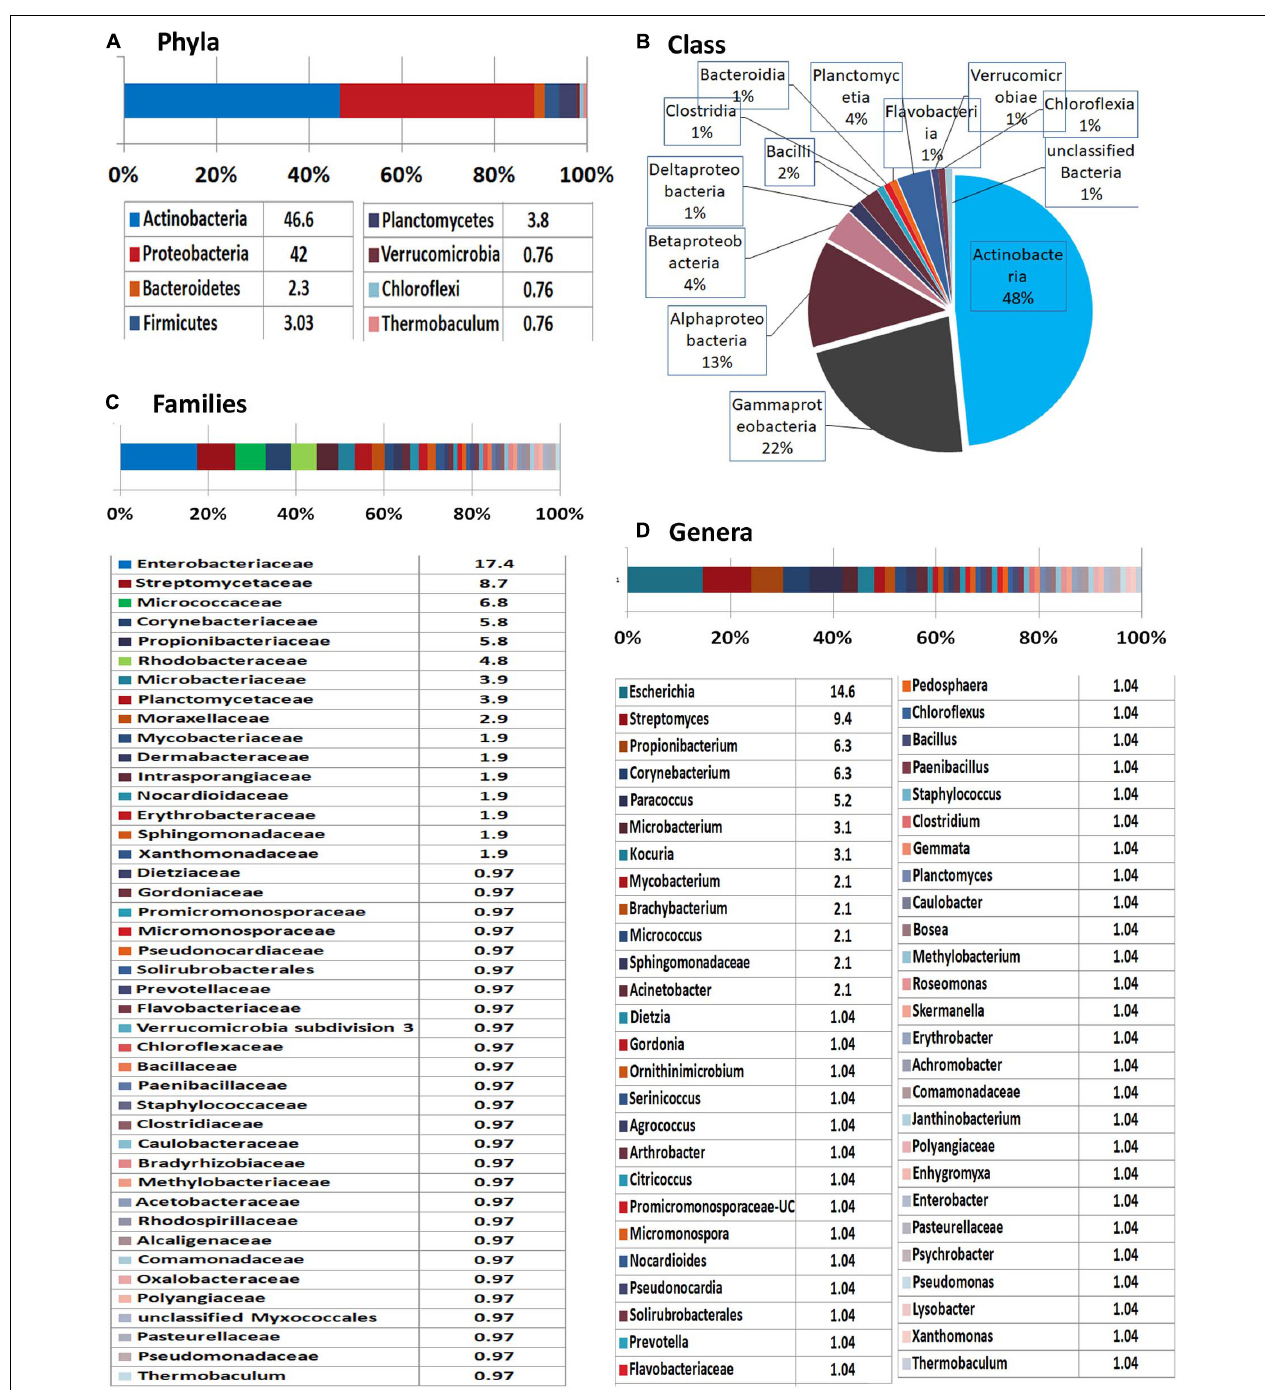
FIGURE 5 | Illumina HiSeq NGS based whole genome metagenomics on watermelon seed-embryos. MEGAN-based taxonomic profiling of bacterial microbiome at the (A) phyla, (B) class, (C) family, and (D) genera levels.